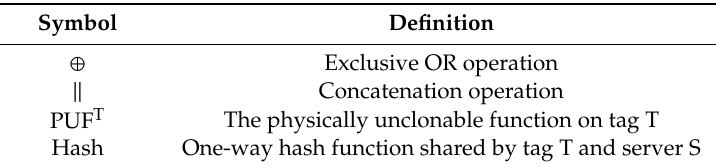
Table 1. Operations and cryptographic functions.